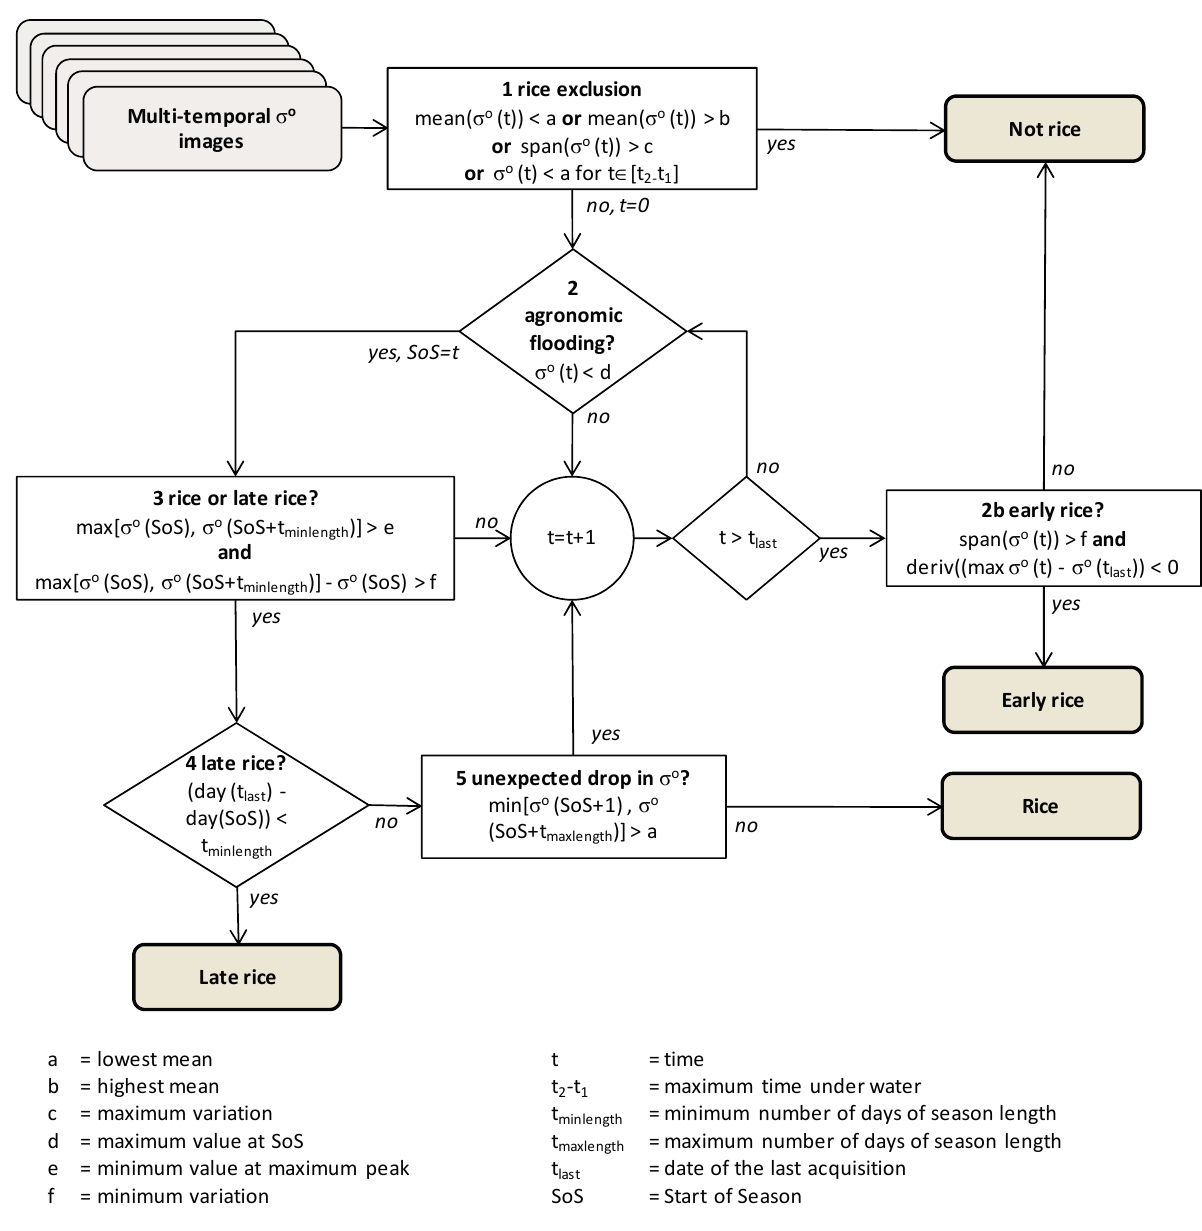
Figure 3. Rule-based rice detection algorithm for multi-temporal X-band σ ° in